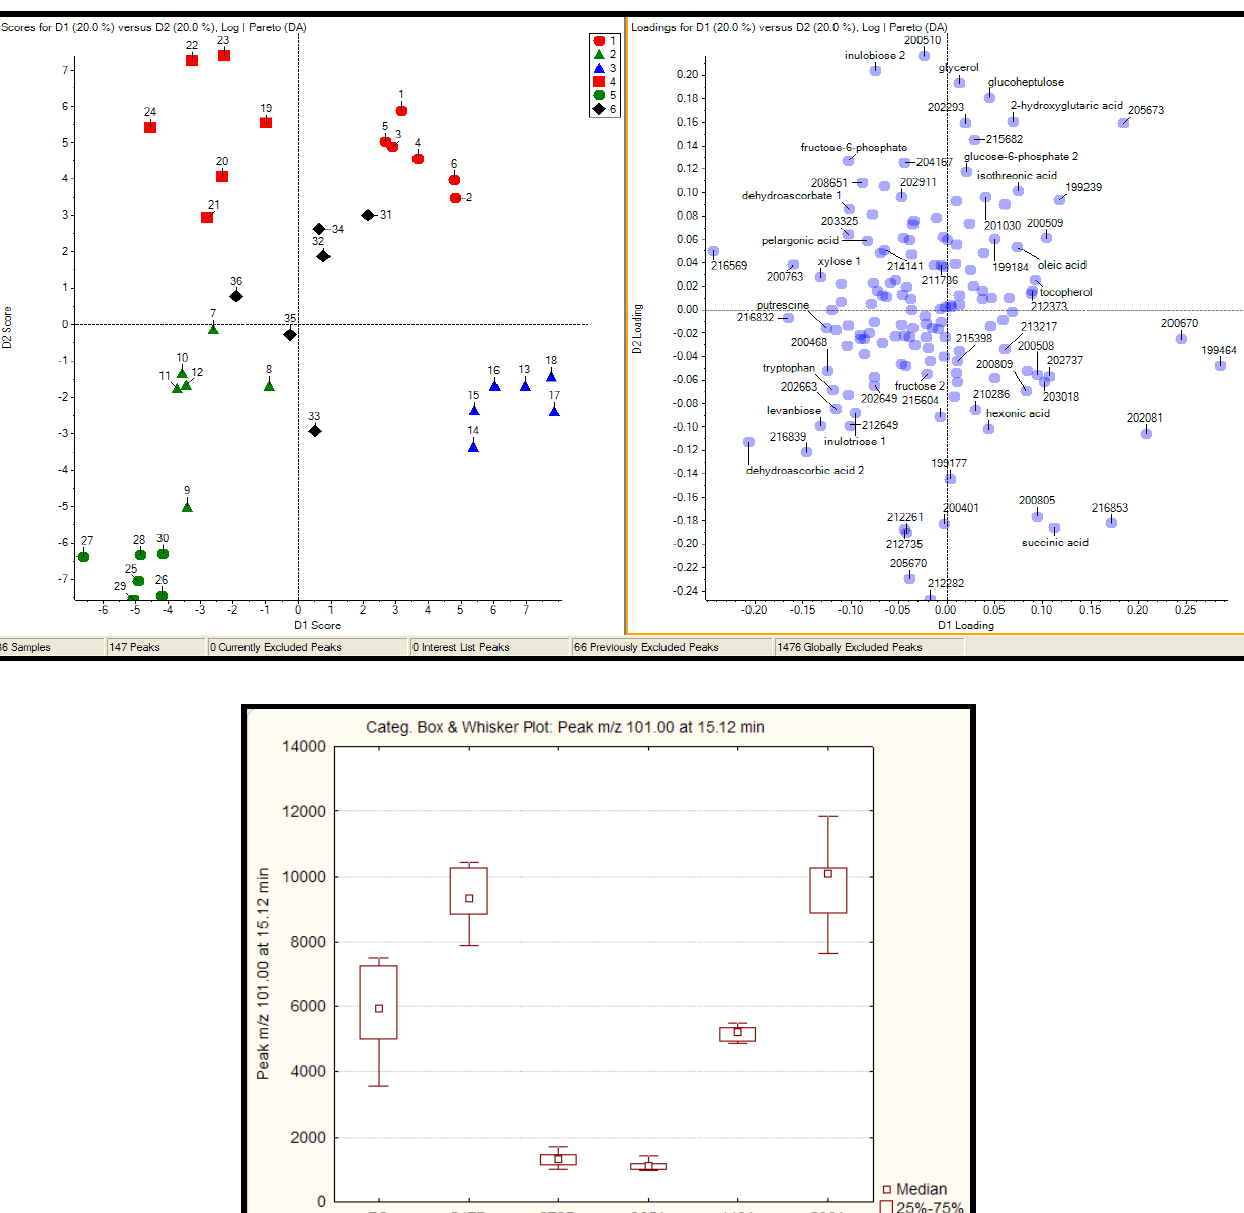
Figure 3a. Upper panel: PCA-DA score and loading plots of the Pinus taeda L. GC–TOF– MS data. Groups (clones) are color-coded in accordance with embedded legend. Software is MarkerView 1.0. Loading plot illustrate resolved annotated by BinBase [35, 36]. Metabolites with chemical names assigned. Unidentified ones named by the numbers. Lower panel: variation of 4- O -galactopyranosyl- D -mannopyranose levels in different six